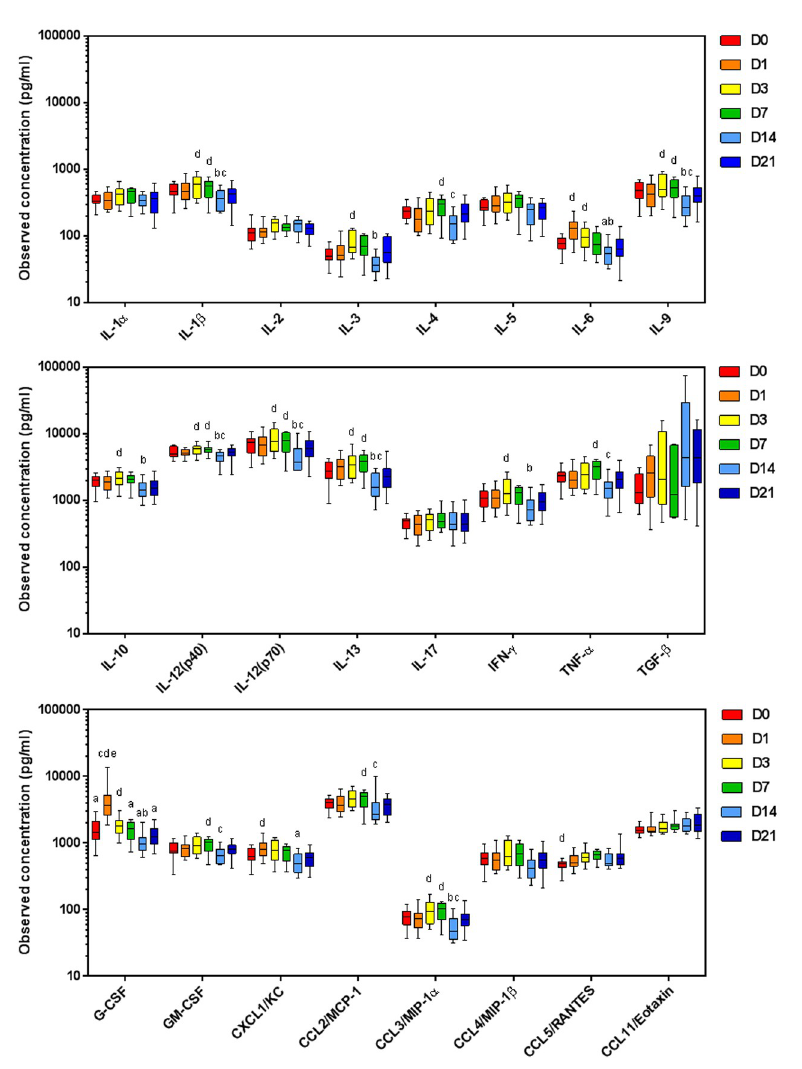
Fig 7. Plasma cytokine and chemokines levels from mice inoculated with glioma Gl261 cells. Plasma was harvested at day 0 (sham) to day 21 time points and assessed by 23-plex immunoassay, except TGF- β 1 (by chromogenic ELISA). Data are expressed as observed concentration in pg/ml. a p < 0.05 vs D14; b p < 0.05 vs D21; c p < 0.05 vs D7; d p < 0.05 vs D3; e p < 0.05 vs D1 by Dunn’s Multiple Comparison